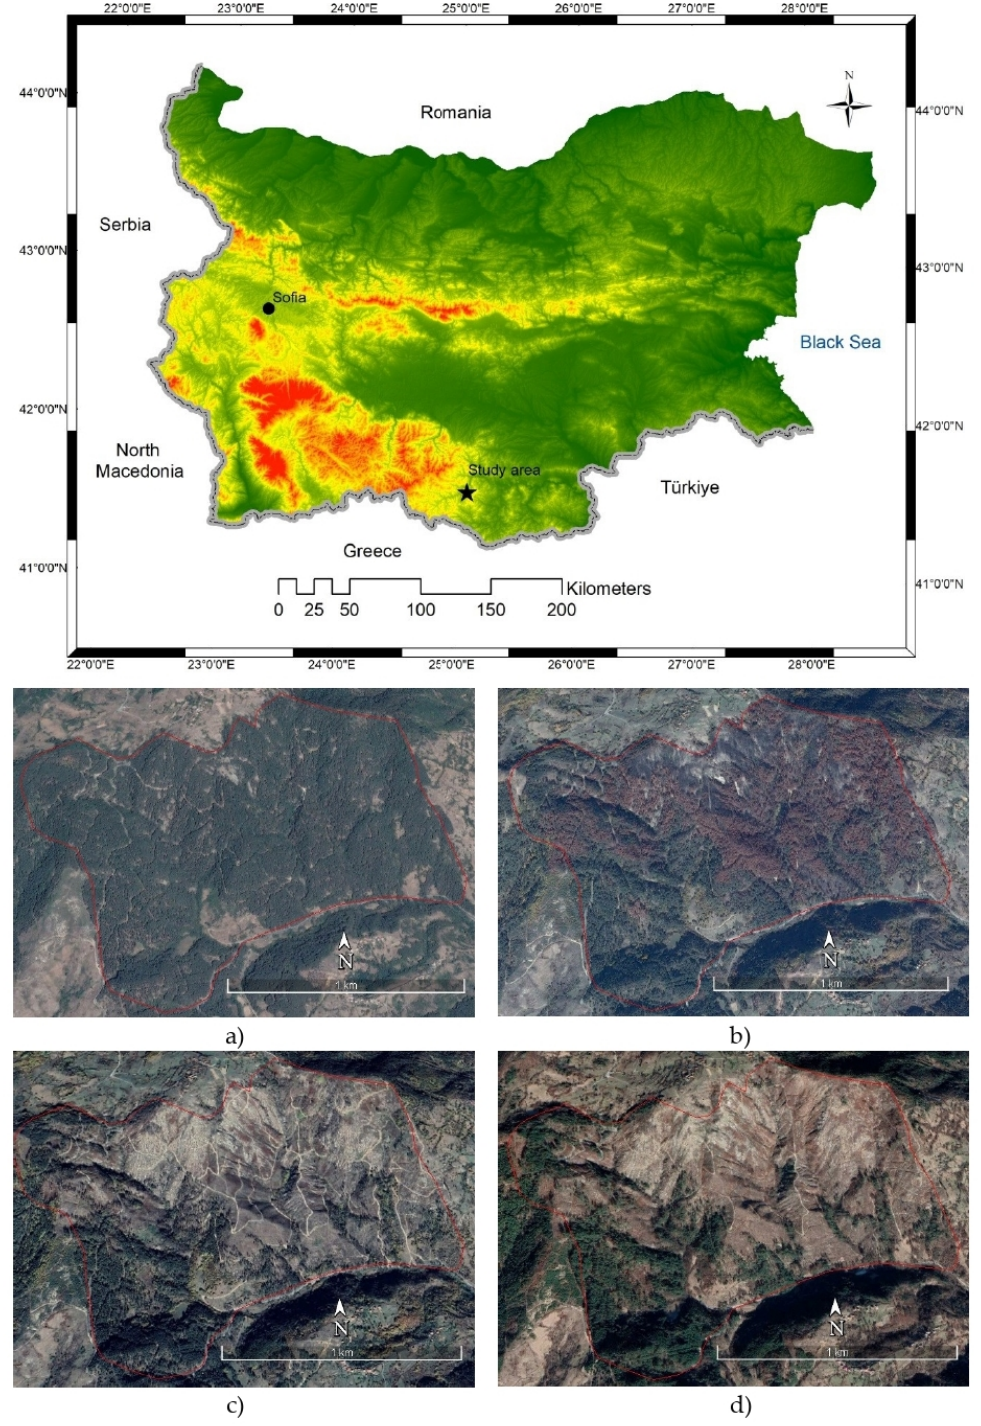
Figure 1. Location of the studied area and land cover change in the pre-fire 2013 ( a ) and post-fire 2016 ( b ), 2018 ( c ), and 2020 ( d ) years. Source: Google Earth Pro—Airbus and Maxar Technologies